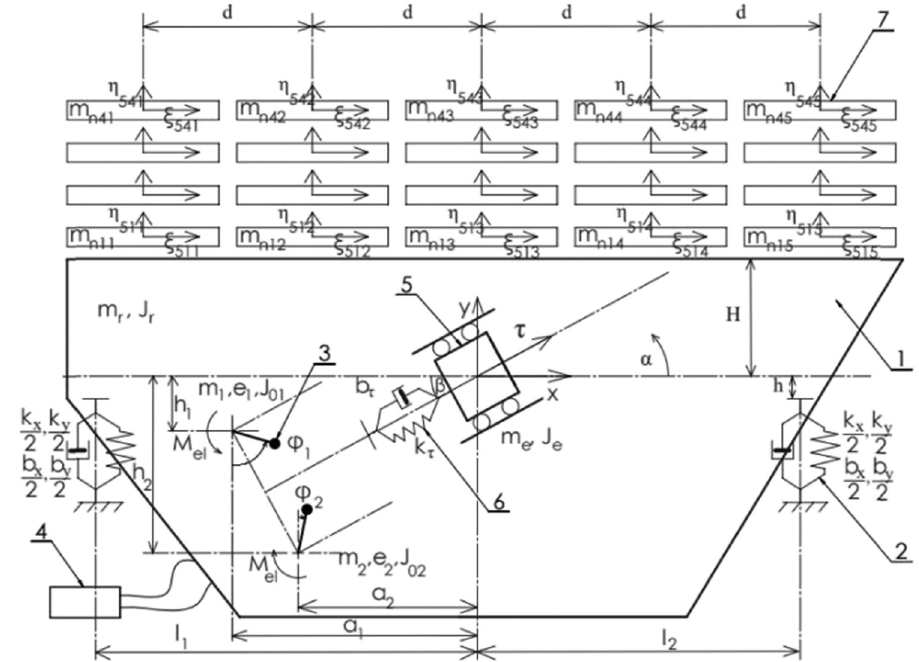
Figure 1: Schematic presentation of the conveyor ( according to the invention )